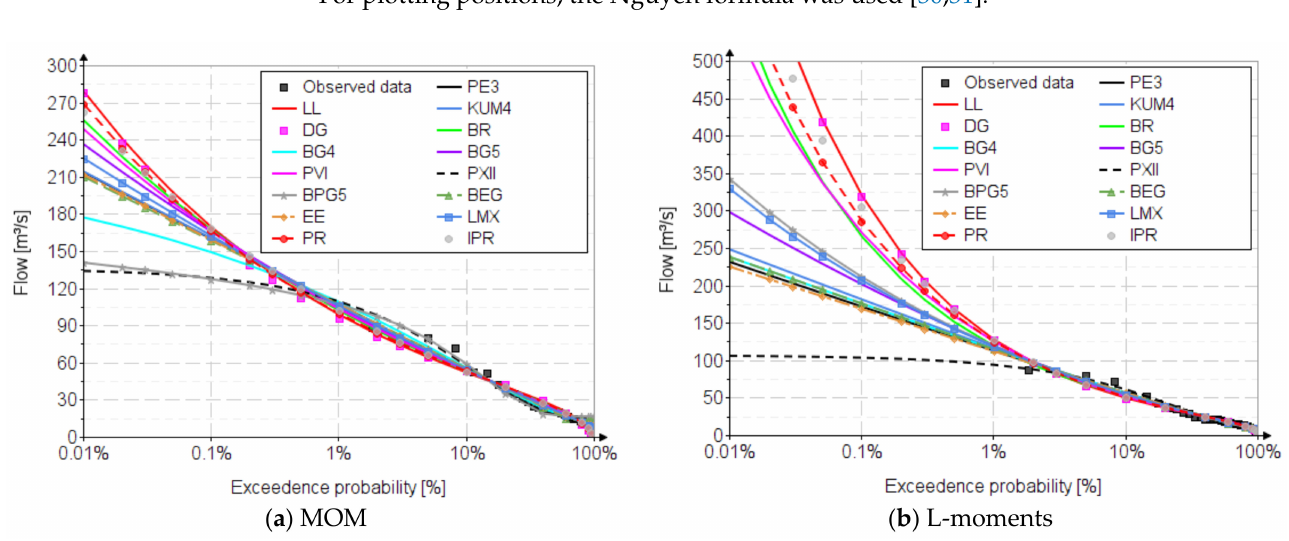
Figure 4. The fitting distributions.